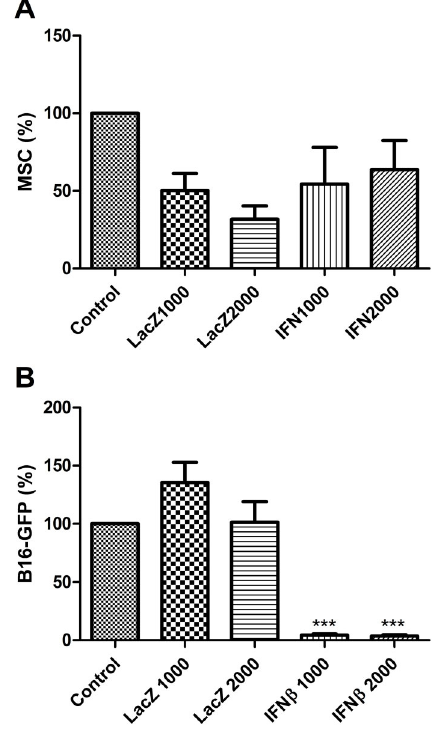
Figure 2. Mesenchymal stem cells (MSCs) producing interferon- b (IFN b ) inhibited co-cultured B16 mouse melanoma cells. MSCs were either not transduced (Control) or transduced with AdRGD- CMV-LacZ (LacZ) or AdRGD-PG-IFN b (IFN b ) at the indicated multiplicity of infection (1000 or 2000) and then co-cultured with B16 cells with stable expression of eGFP (B16-GFP) and, 96 h later, each cell population was counted based on the presence or absence of eGFP expression. Quanti fi cation of the ( A ) MSC or ( B ) B16-GFP populations is reported as the average and standard error from three independent experiments, normalized by the value obtained for the Control group. ***P o 0.001, statistical analysis was performed comparing individual experi- mental conditions with the control using Student ’ s t -test. GFP: green fl uorescent